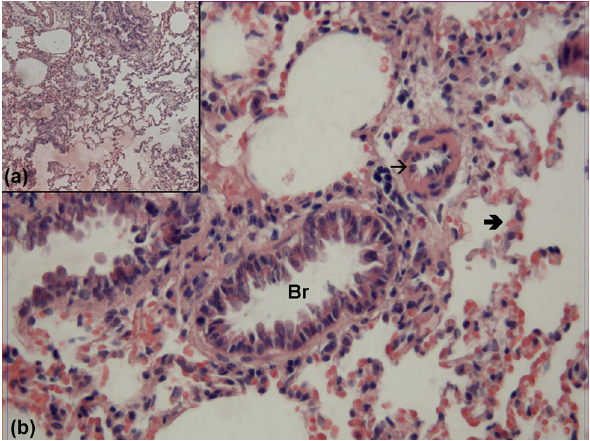
Figure 1: Hematoxylin – eosin - stained lung samples obtained from the SHAM group. Br: bronchioles, (cid:2) : alveoli, → : vessel ( hemato - xylin – eosin, A: × 100, B: × 400 )